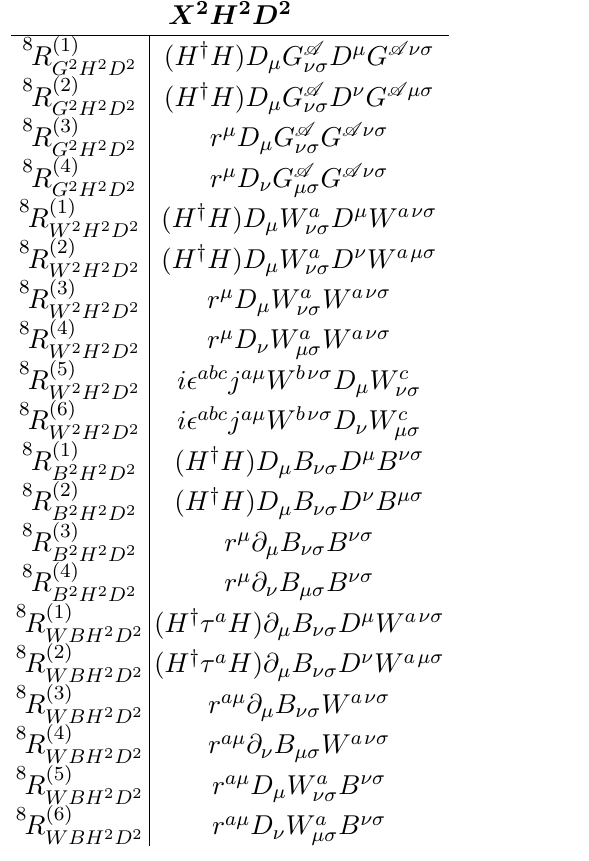
Table 8 . Redundant bosonic dimension-eight operators in the SMEFT, part